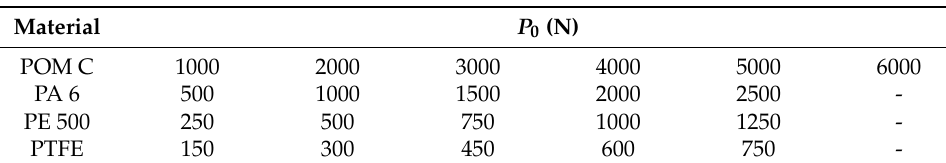
Table 1. Creep loads P 0 used in the CCRTs.